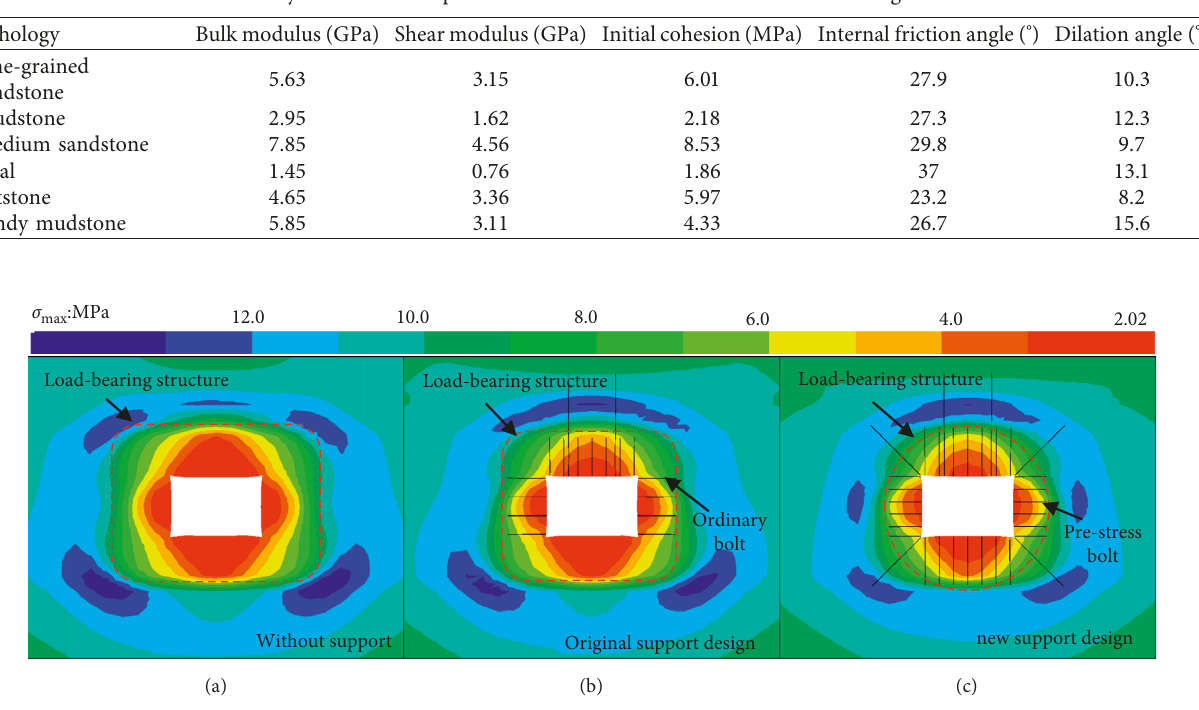
Figure 7: Load-bearing structure and tangential stress distribution of roadway surrounding rock mass under different conditions.